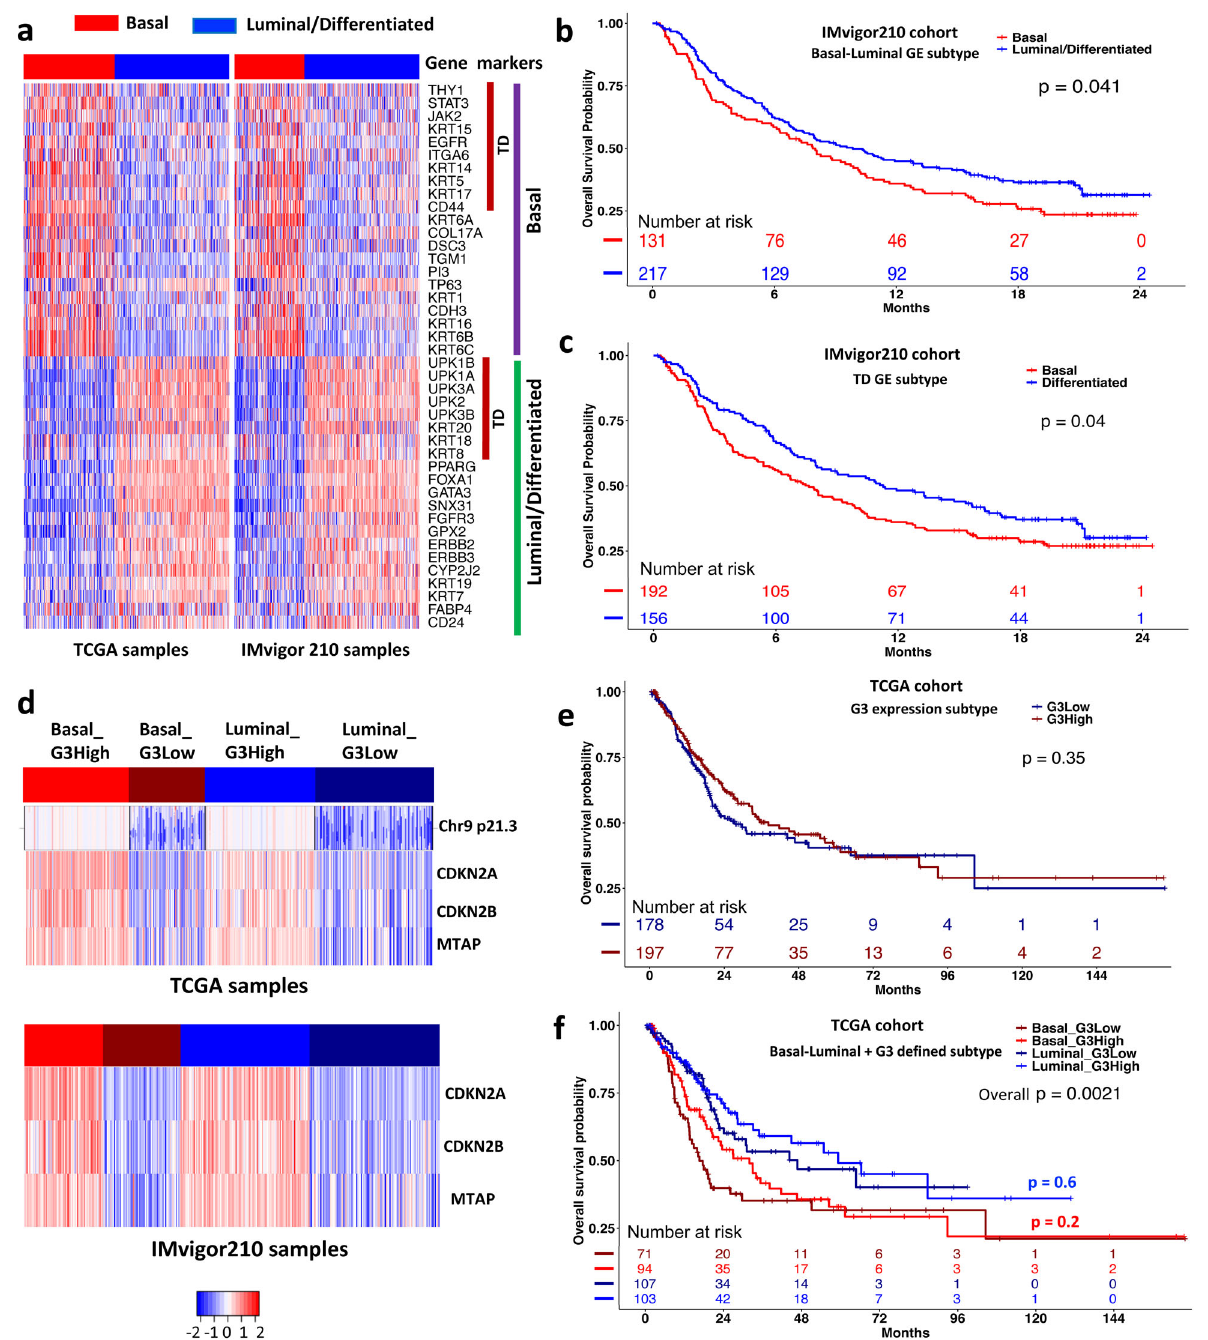
Fig. 3 Prognostic power of tumor differentiation (TD) and basal-luminal gene expression signatures. a Heatmaps of gene expression of 42 basal-luminal genes (including 18 TD genes) in the TCGA ( n = 388) and IMvigor210 (n = 348) cohorts. b , c Patient overall survival strati fi ed by the basal and luminal subtypes de fi ned by the 42 basal-luminal genes ( b ), and by the basal and differentiated subtypes de fi ned by the 18 TD genes ( c ) in the IMvigor210 cohort. d Heatmaps of G3 ( MTAP/CDKN2A/2B ) expression in the basal and luminal/differentiated subtypes in the TCGA and IMvigor210 cohorts, which were further divided into relatively G3 high expression (G3High) or low expression (G3Low) subgroup. On the top panel, the copy number data of chr9 p21.3 are aligned with the G3 expression data in the TCGA cohort, indicating a high concordance between copy number and gene expression. e Overall survival strati fi ed by the G3High and G3Low groups in the TCGA cohort (375 non-NAC patients). f Overall survival strati fi ed by the Basal_G3High, Basal_G3Low, Luminal_G3High, and Lumina_G3Low groups in the TCGA cohort (375 non-NAC patients). Log-rank test was used to compare subtype-speci fi c survival